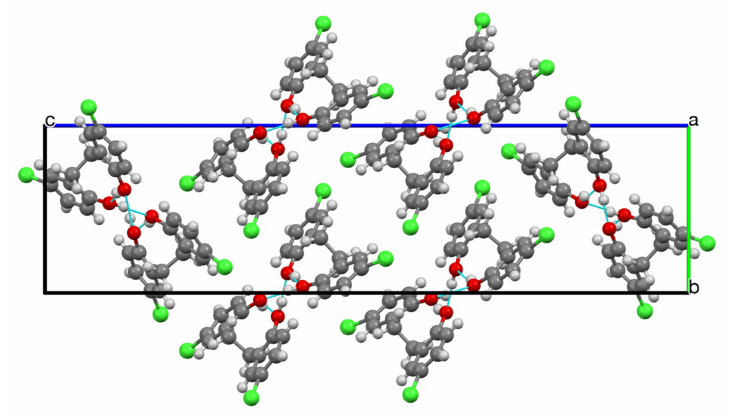
Figure 3. Unit cell viewed along the a axis showing the arrangement of hydrogen-bonded